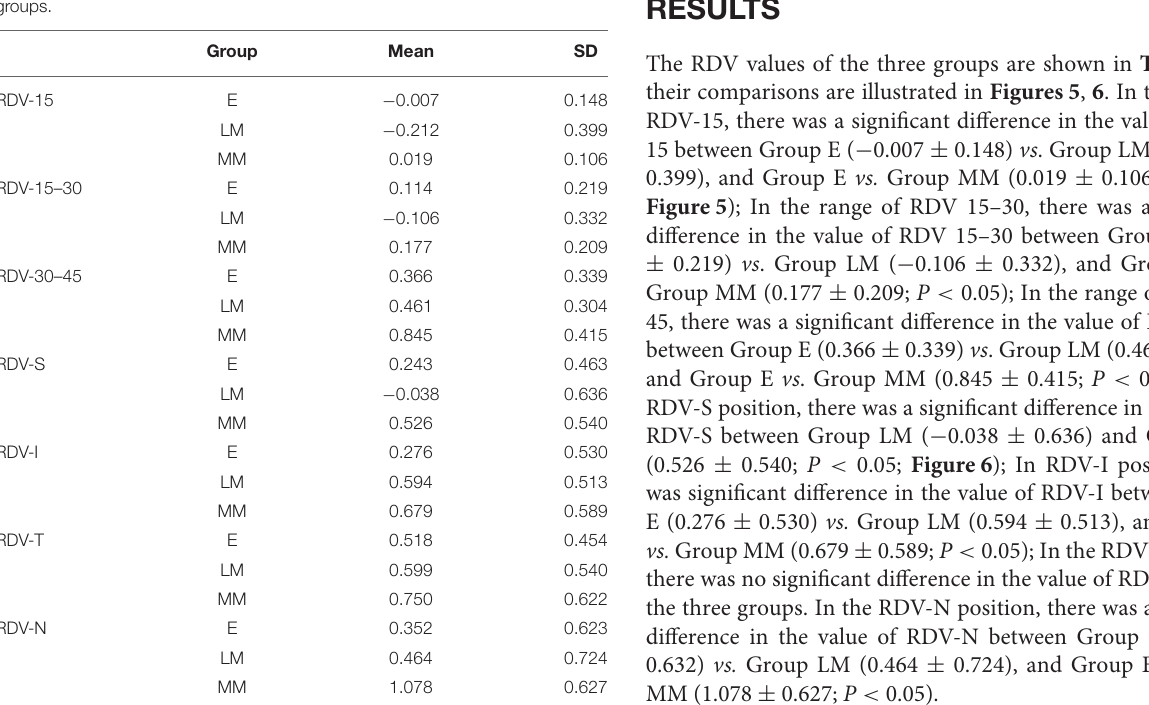
TABLE 2 | The retinal relative diopter (RDV) values in different ranges of the three groups.